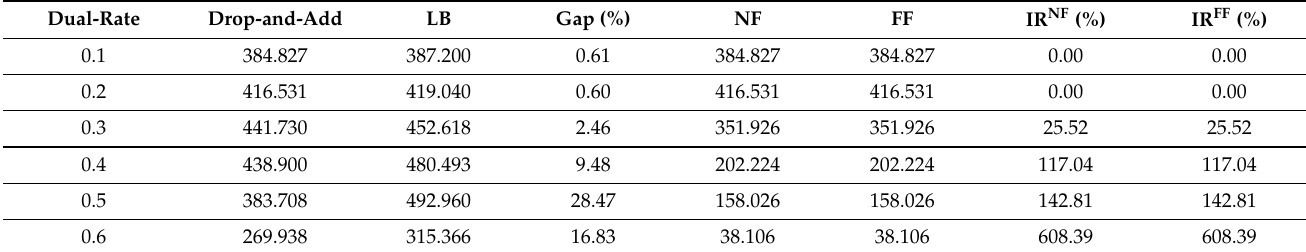
Figure 8. Objective value when scaling the dual-rate. Table 9. Comparison of solution qualities under different the